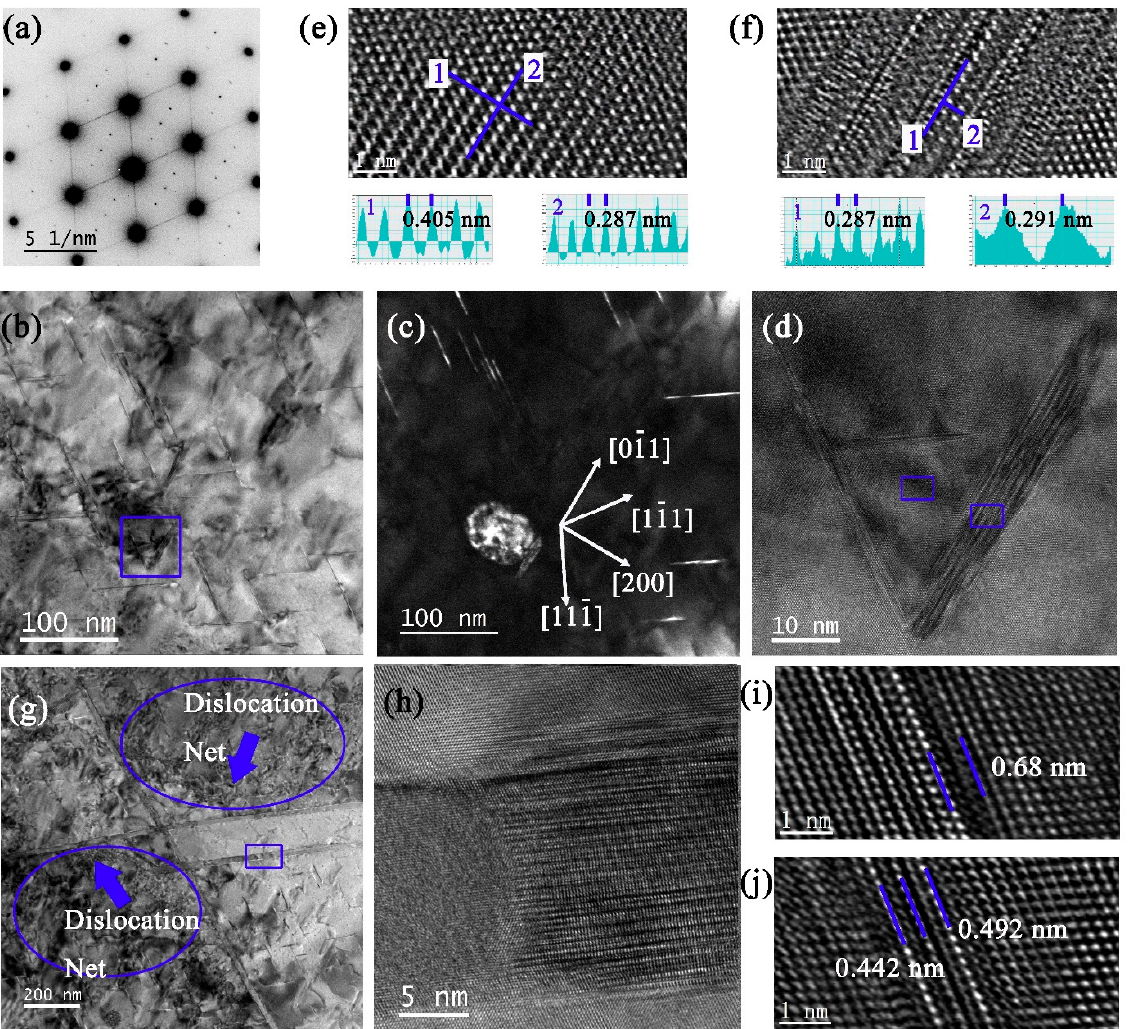
Figure 11. TEM analysis of 9# after 12 h creep. ( a ) SADP under [110] α . ( b ) BF and ( c ) DF of ( b ). ( d ) Enlarged BF selected by blue square box in ( b ), with HRTEM measured in ( e , f ). ( g ) BF with initial T 1 phases and dislocation nets. ( h ) HRTEM of initial T 1 phase by enlarging the blue box in ( g ). ( i ) and ( j ): two separate HRTEM images of secondary T 1 phase.